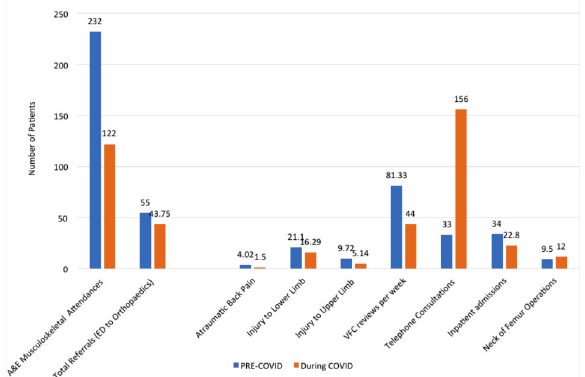
Graph showing decline in total A&E attendances with a Fig. 2: musculoskeletal complaint.